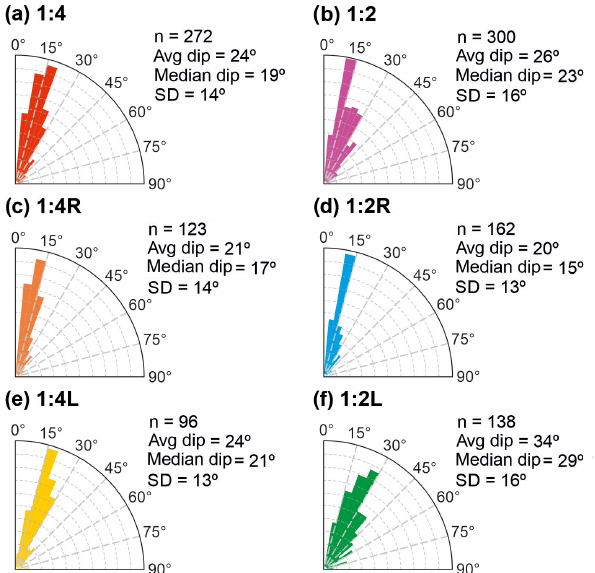
Figure 6. Rose diagrams showing the dips of interpreted faults. Fault dips interpreted at a vertical exaggeration of (a) 1 : 4, (b) 1 : 2, (c) 1 : 4 dipping rightward (“R”), (d) 1 : 2 dipping rightward, (e) 1 : 4 dipping leftward (“L”) and (e) 1 : 2 dipping leftward. The “ n ” marks the number of faults analysed. “SD” stands for standard de- viation.